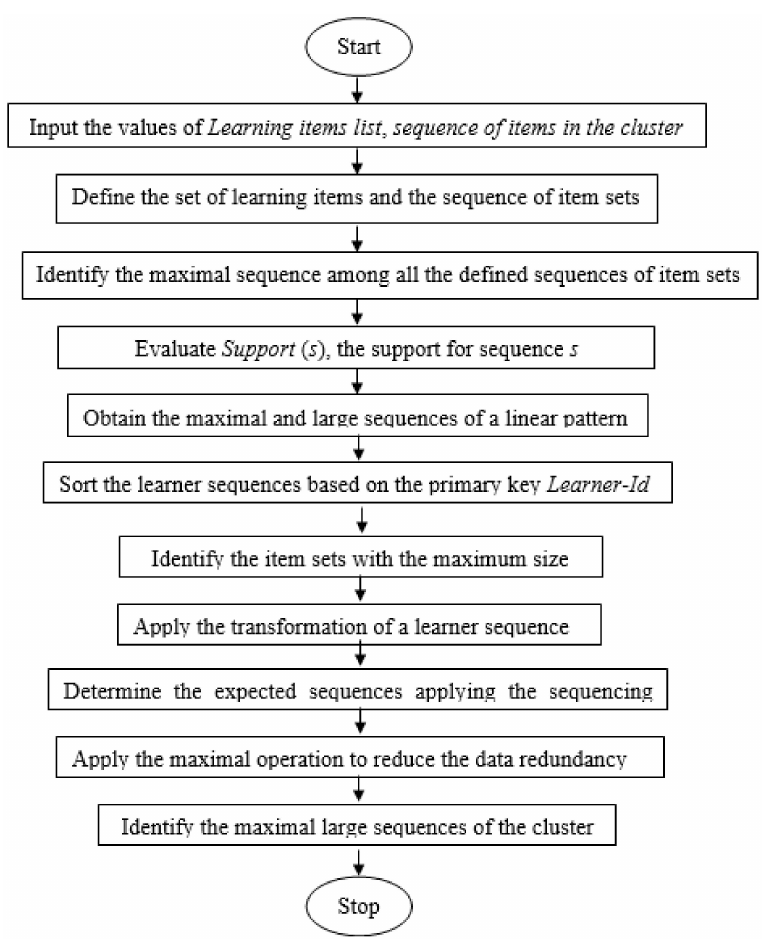
Figure 4. The proposed cluster-based linear pattern